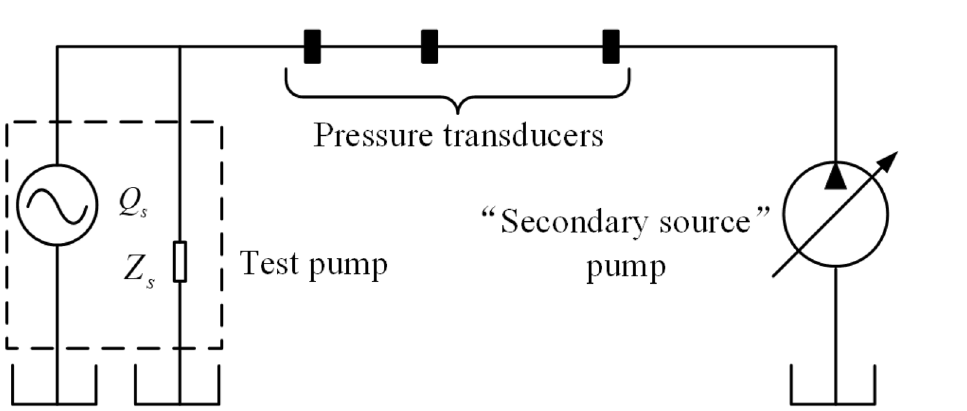
Figure 25. Schematic illustrating the secondary source test method.